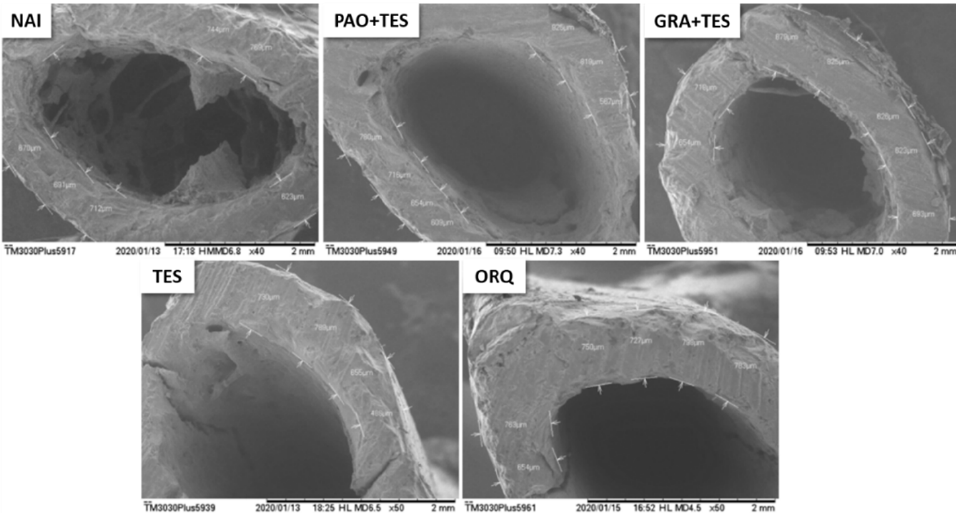
Figure 5. Representative scanning electron microscopy (SEM) of transversal sections of the femur body after 45 days of each group treatment. All the pictures were taken from the same area (in 2 mm scaled) across the groups to ensure uniformity of the results. No statistical divergences were observed among groups. NAI: control naïve group; PAO + TES: orchiectomized group treated with purified annatto oil (200 mg/kg, p.o.) + testosterone (7 mg/kg, IM); GRA + TES: orchiectomized group treated with PAO granules (200 mg/kg, p.o., Chronic ® ) + testosterone (7 mg/kg, IM); TES: orchiectomized group treated only with testosterone (7 mg/kg, IM); ORQ: orchiectomized group treated only with